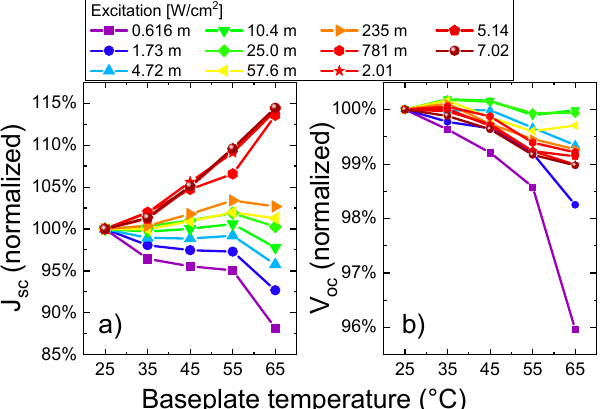
Figure 4. Short-circuit current (theoretical estimation with dashed line, measured values with solid lines) ( a ) and open-circuit voltage ( b ) with respect to excitation density at various baseplate temperatures.